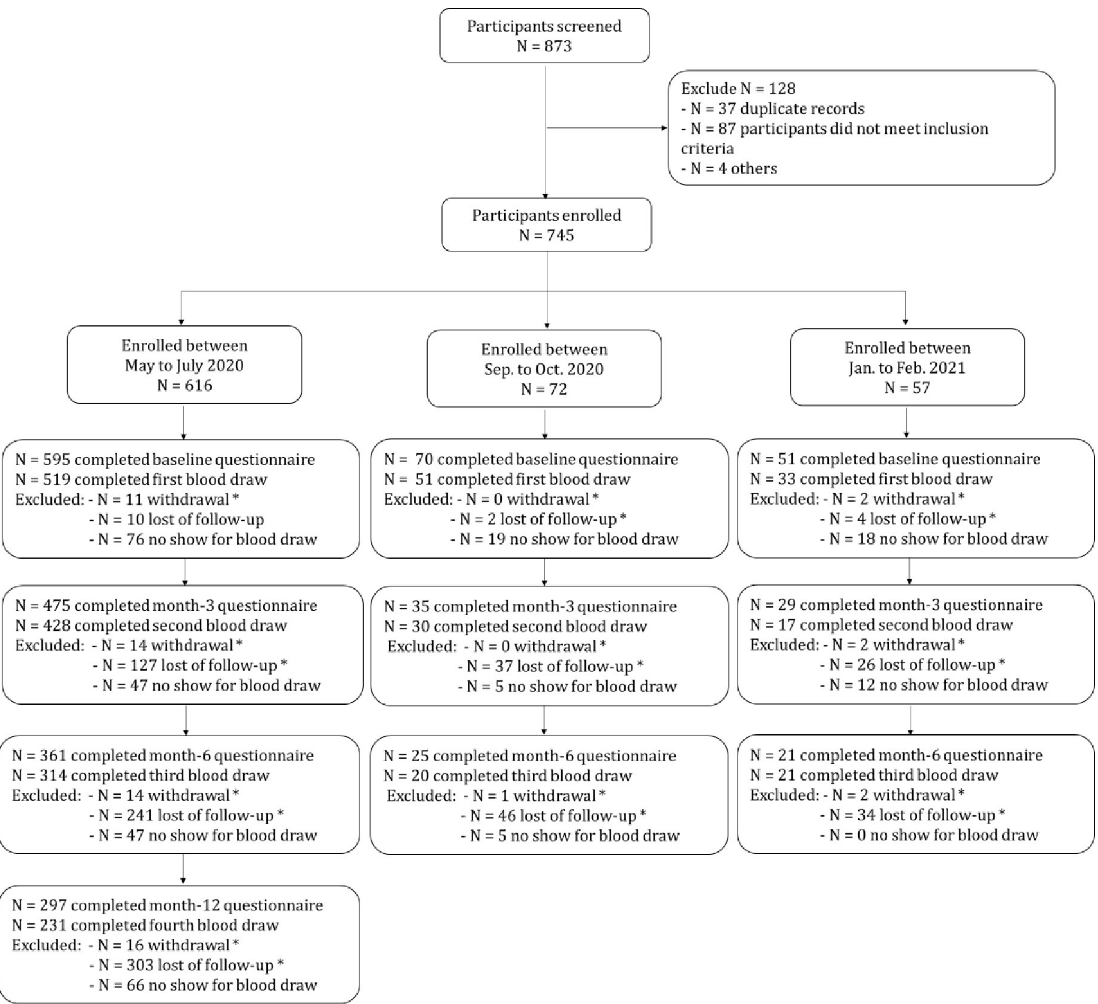
Fig 1. Consort diagram by the 3 rd open (Month 6 follow up). Legend: � Withdrawal and lost to follow-up are calculated from initial enrollment in that time period (ie. for those initially enrolled May to July 2020, 127 lost to followup at 3 month questionnaire was compared to N = 616). However, no show for blood draw is within the time point only (eg. for participants enrolled between May and July 2020, at the 3 month time point, 475 completed the questionnaire but only 428 had blood drawn, ie. 47 did not show for 3 month blood